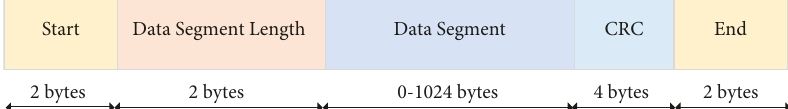
Figure 3: Modbus frame